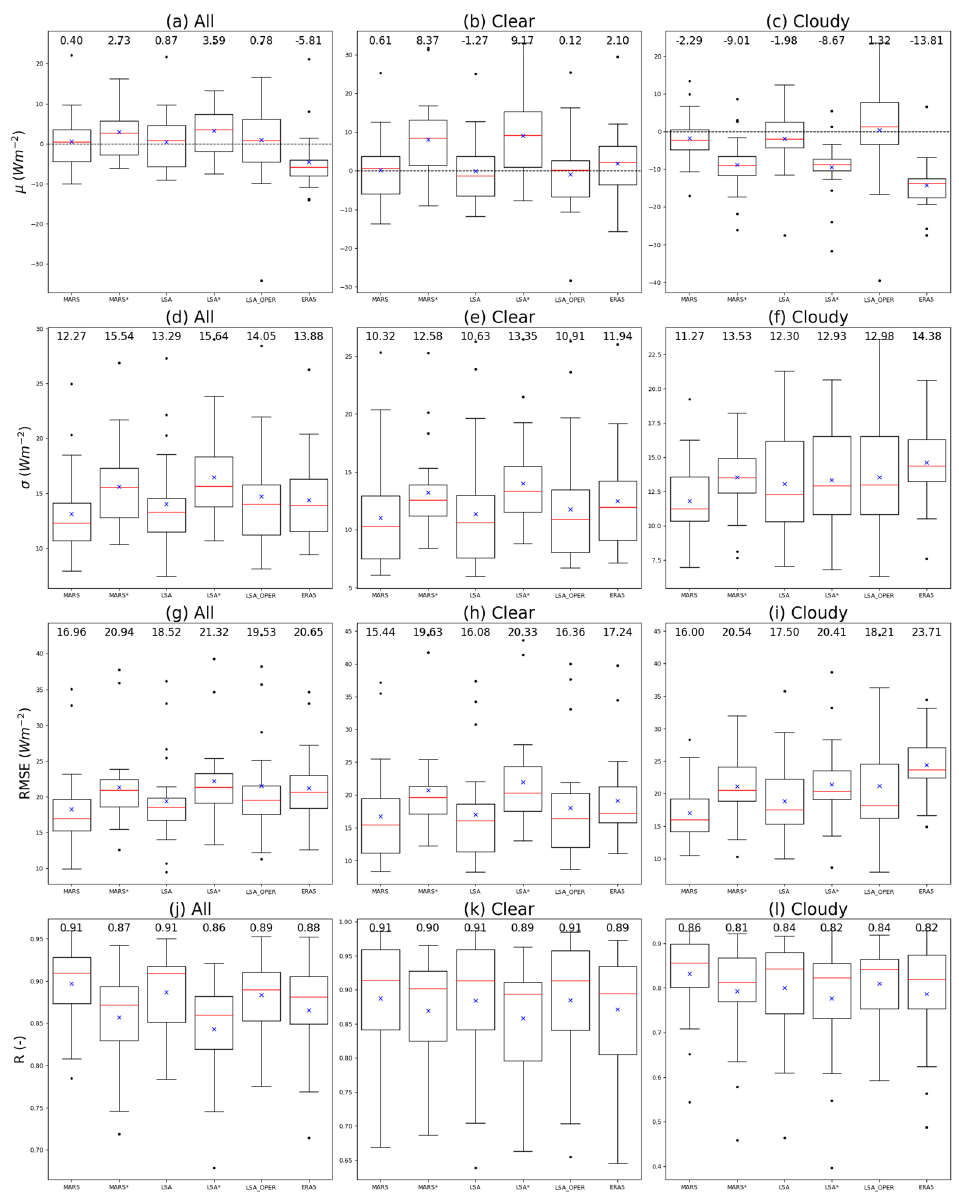
Figure 3. Distribution of the metrics computed for each station displayed as boxplots for all, clear, and cloudy-sky conditions (i.e., left, middle, and right column, respectively): bias, µ in ( a – c ), standard deviation of the error, σ in ( d – f ), root mean square error, RMSE in ( g – i ), and the correlation coefficient, R in ( j – l ). The red line and blue cross inside each boxplot identify the median and mean of the distribution, respectively, with the boxes extending from the 25th to the 75th percentiles and whiskers 1.5 times the interquartile range. Units are in W · m − 2 , while correlations are given between 0–1.